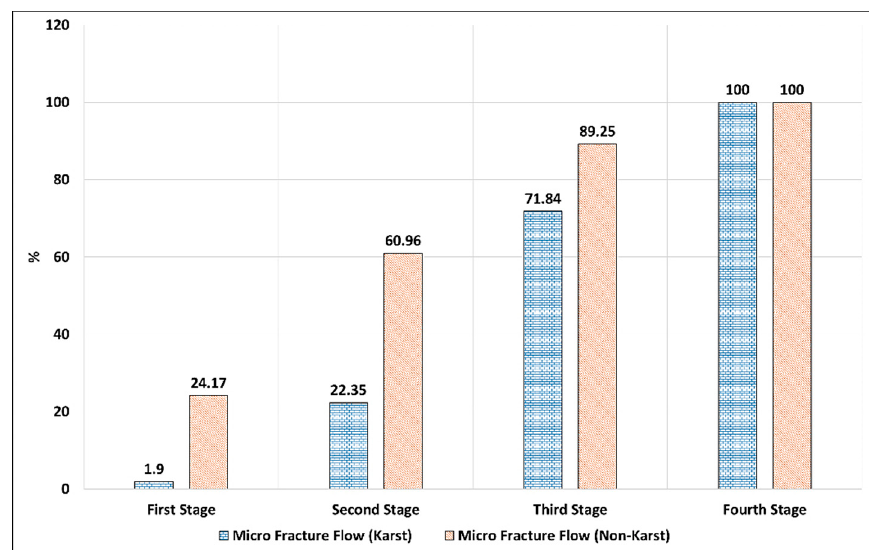
Figure 12. Contrast in Micro Fracture Flow Volume for all four recession stages.